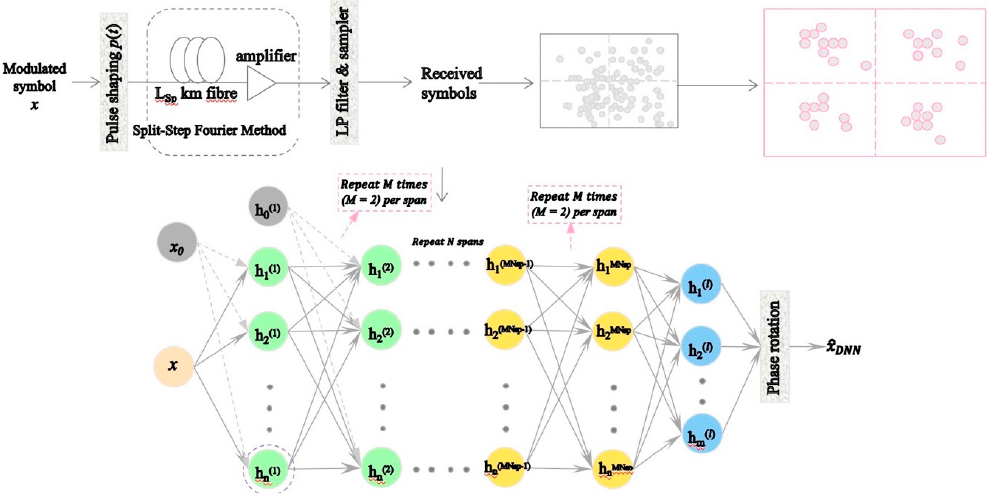
Figure 17. Block diagram of machine learning for symbol classification .